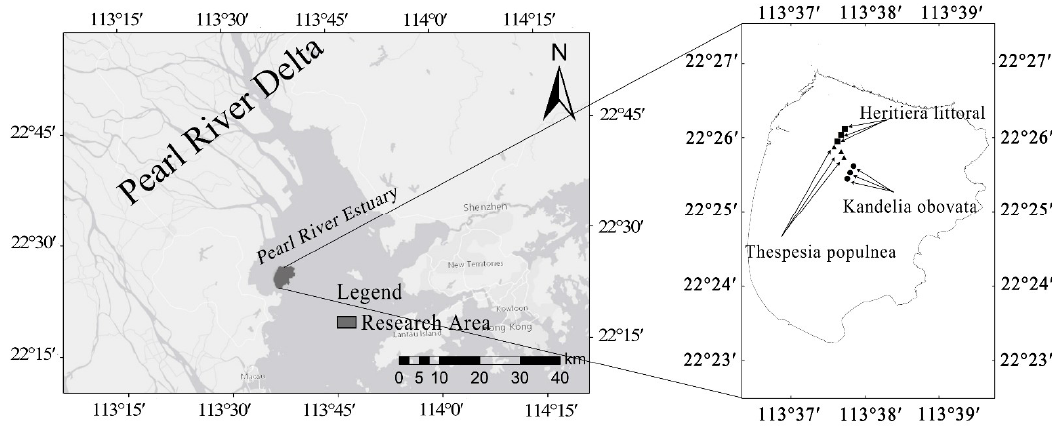
Figure 1. Location map of the study area showing the sampling sites.